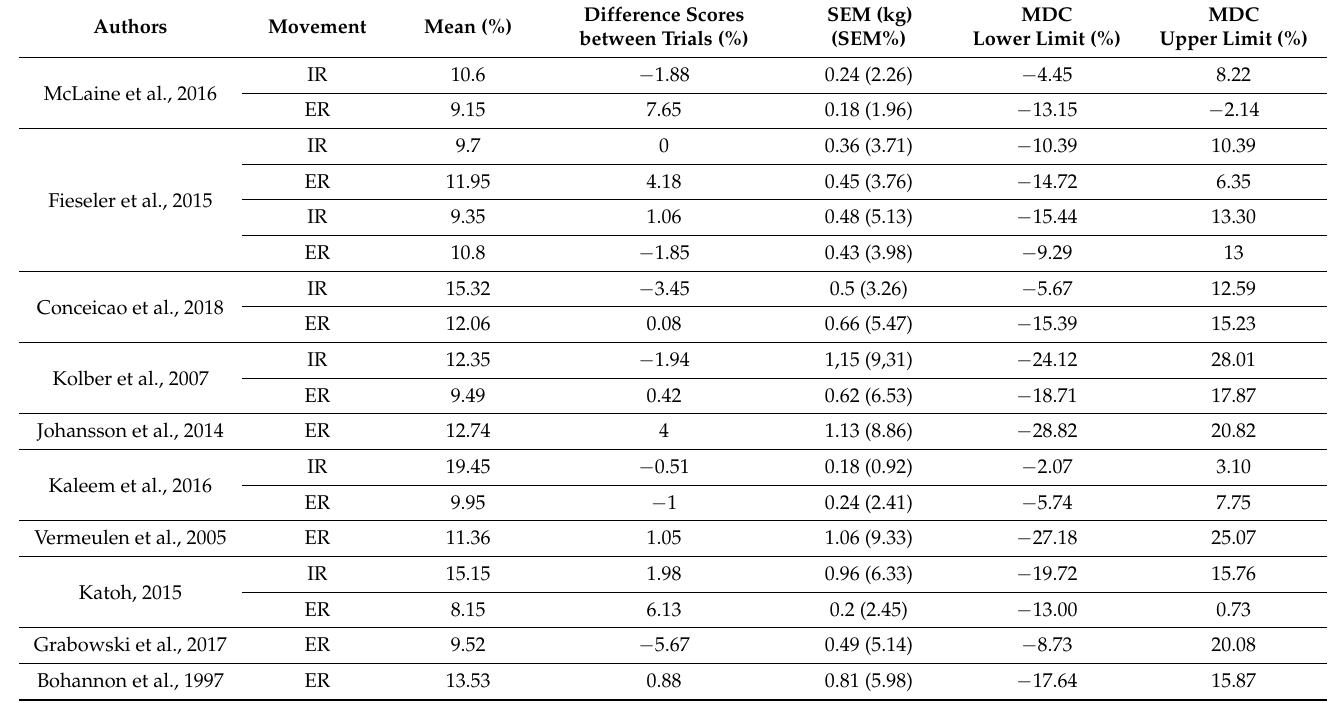
Table 2. Outcome descriptions of studies analyzing absolute reliability of HHDs.